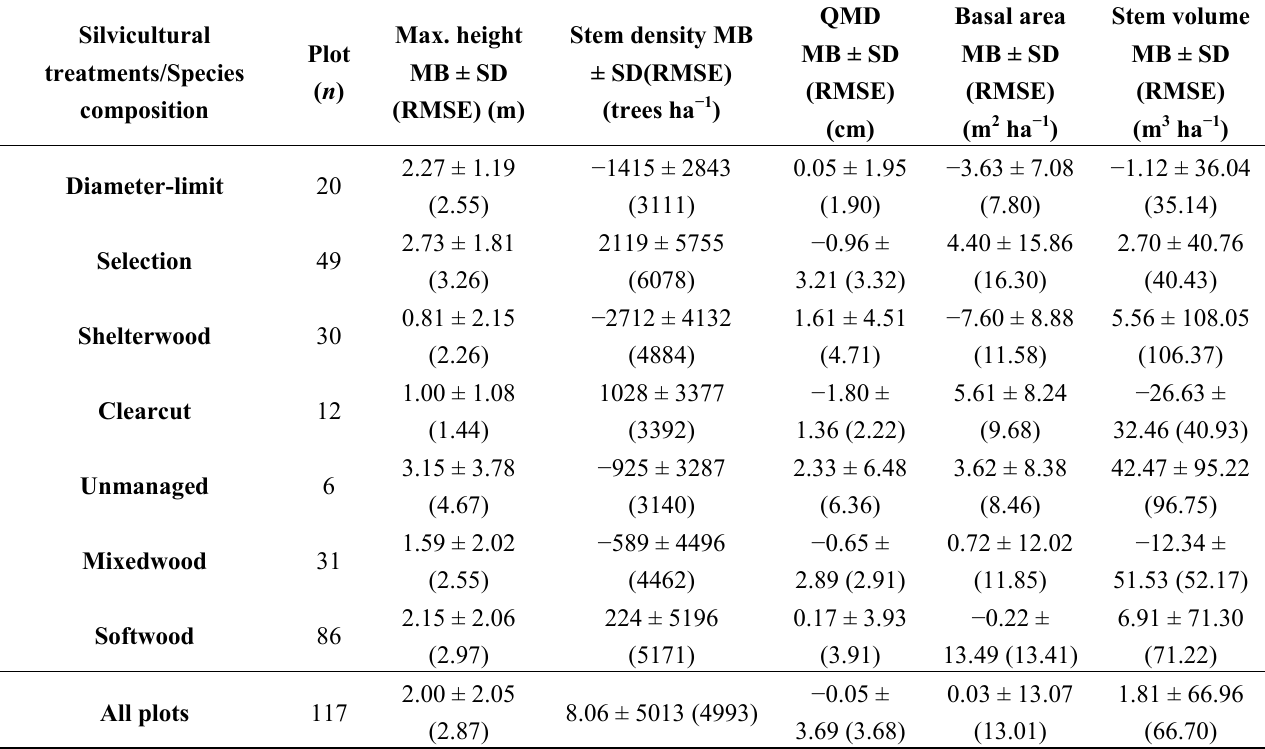
Table 4. Mean bias (MB) with standard deviation (SD) and root mean square error (RMSE) by silvicultural treatments and species composition. Mixedwood plots had a percent of basal area of softwood <70, and softwood-dominant plots had a percent of basal area of softwood ≥70.